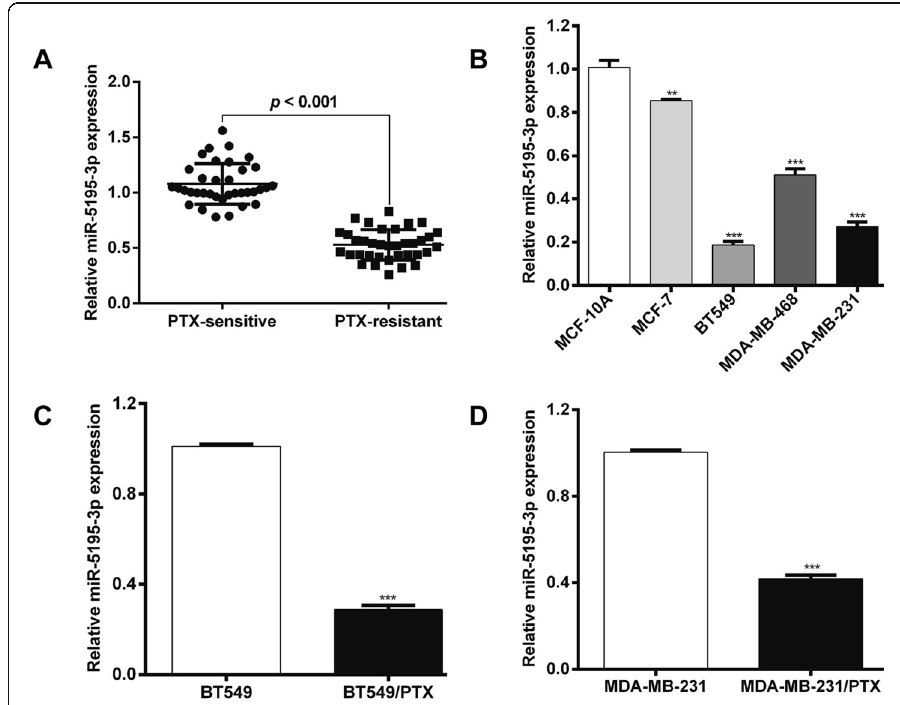
Fig. 1 MiR-5195-3p was downregulated in paclitaxel-resistant breast cancer tissue and cells. a Using quantitative real-time PCR, the expression of miR-5195-3p was determined in breast cancer samples from 36 patients: 18 with paclitaxel-sensitive tumors and 18 with paclitaxel-resistant ones. b The expression of miR-5195-3p was determined in the indicated breast cancer cell lines and in the normal breast epithelial cell line (MCF-10A). ** p < 0.01, *** p < 0.001 vs. MCF-10A. c and d The expression of miR-5195-3p was determined in paclitaxel-resistant BT549 and MDA-MB-231 cells and the corresponding parental cell lines. *** p <0.001 vs. BT549 or